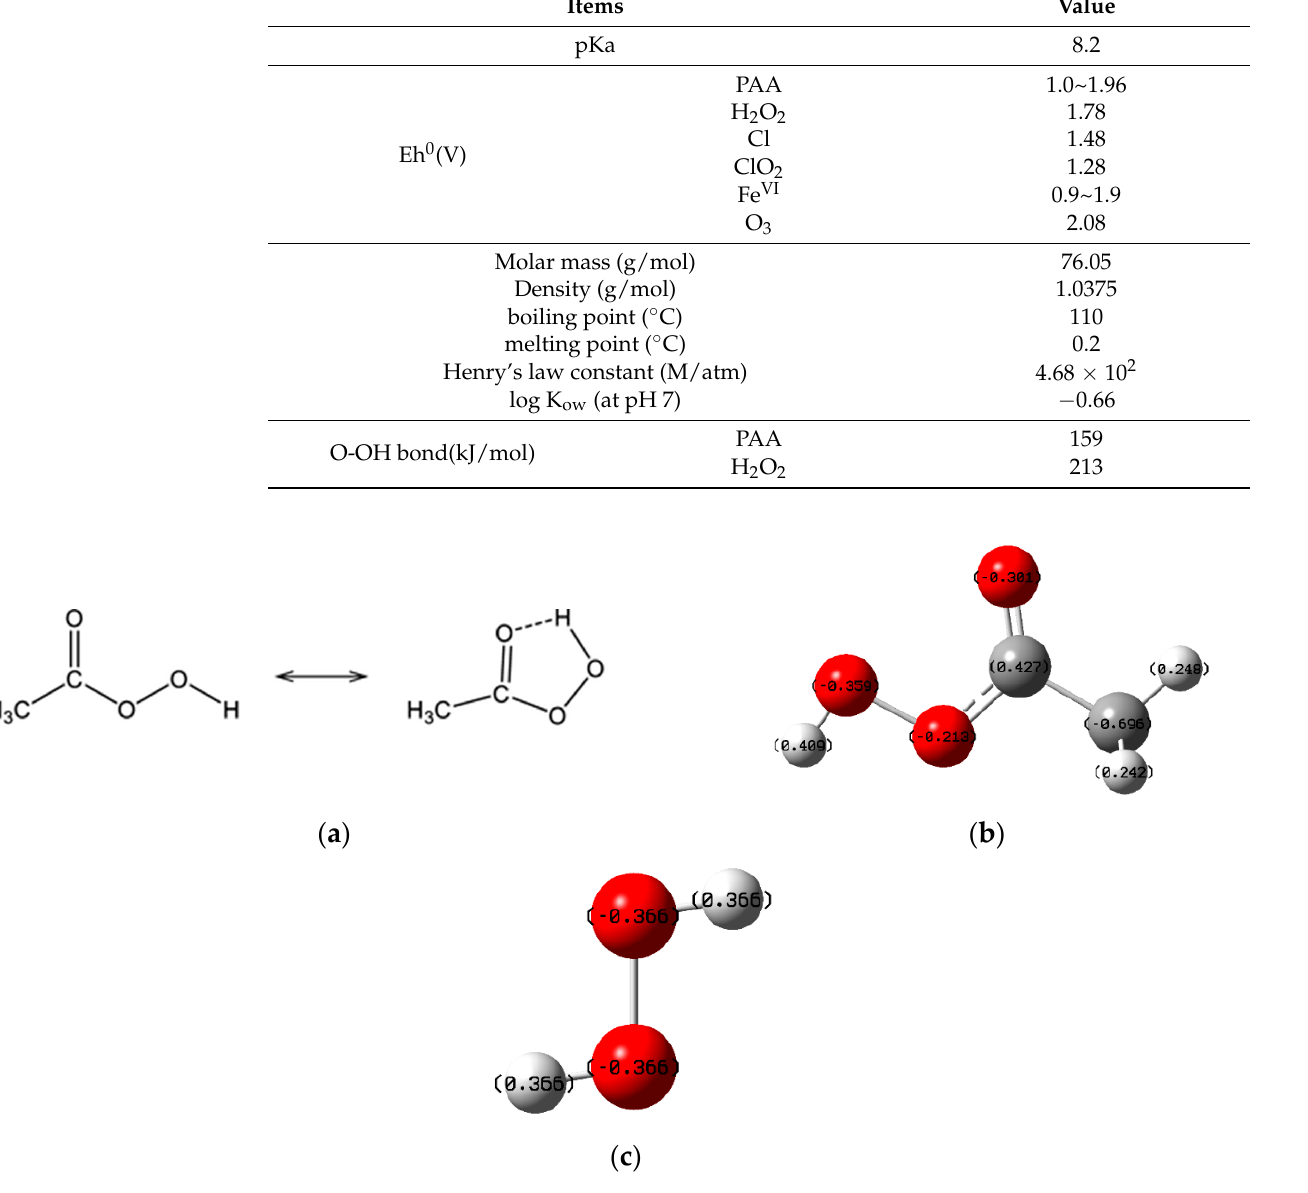
Figure 1. ( a ) PAA molecular formula; Molecular electrostatic potential diagram of ( b ) PAA and ( c ) H 2 O 2